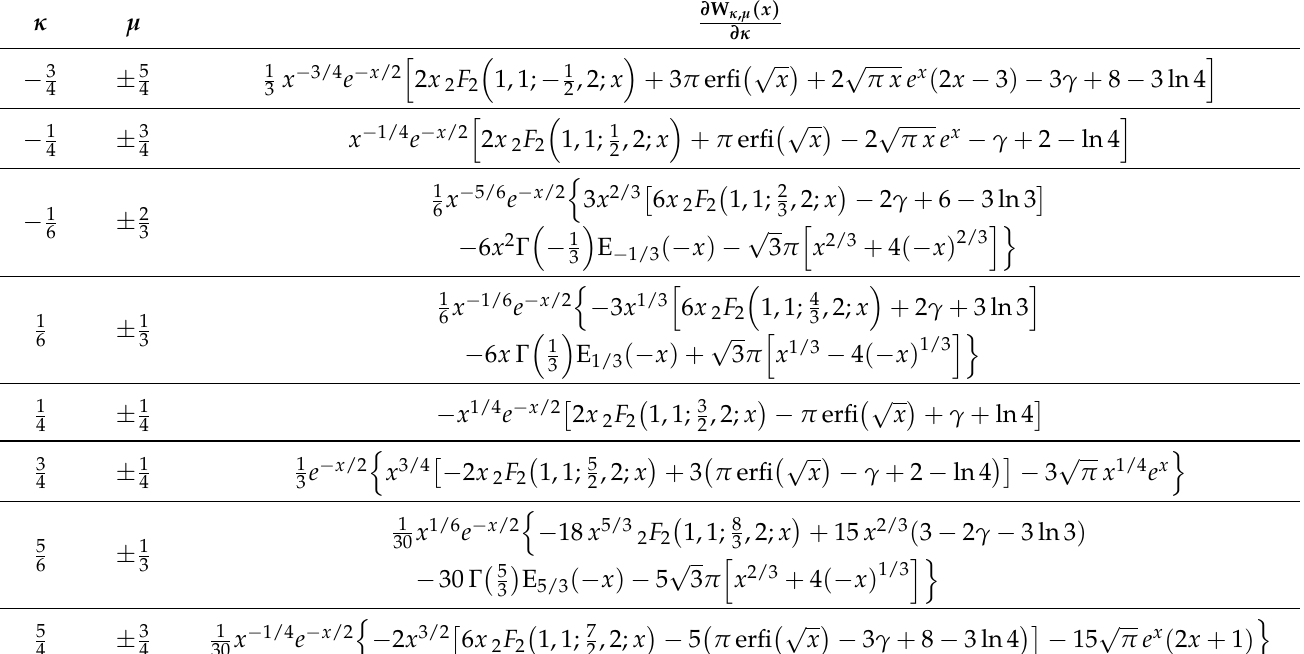
Table 1. Derivative of W κ , µ with respect to κ , by using